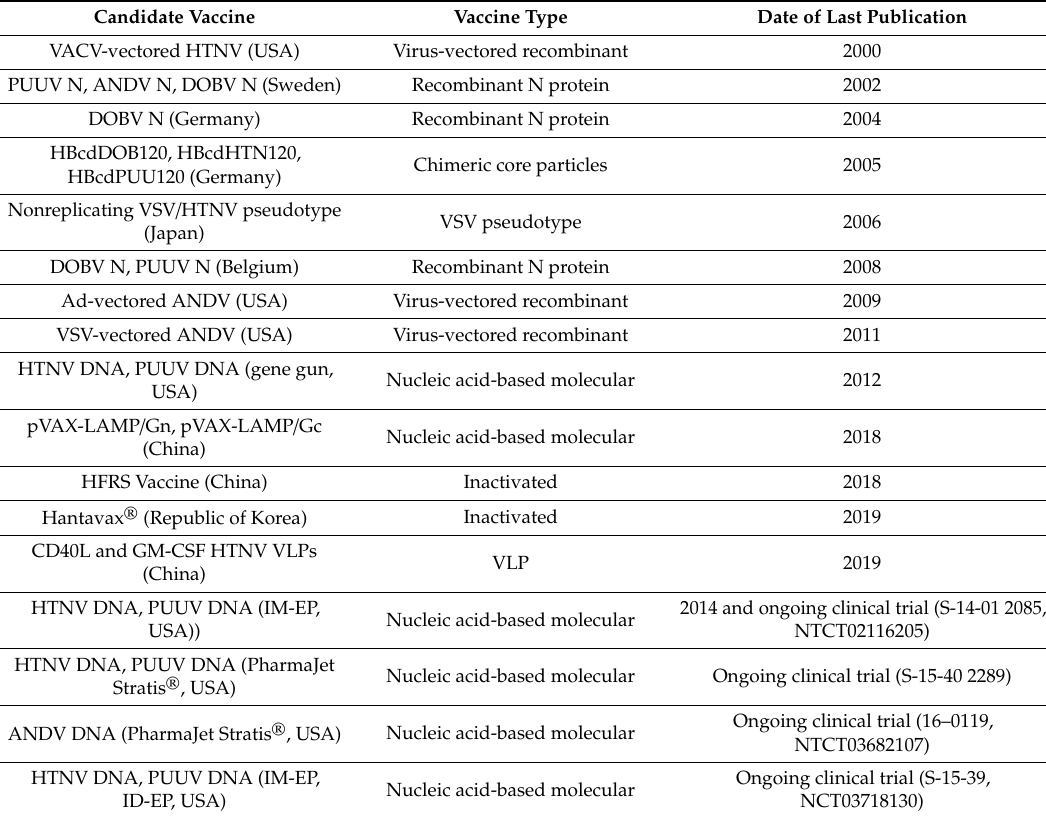
Table 1. Hantavirus candidate vaccines. ANDV: Andes virus; DOBV: Dobrava virus; HTNV: